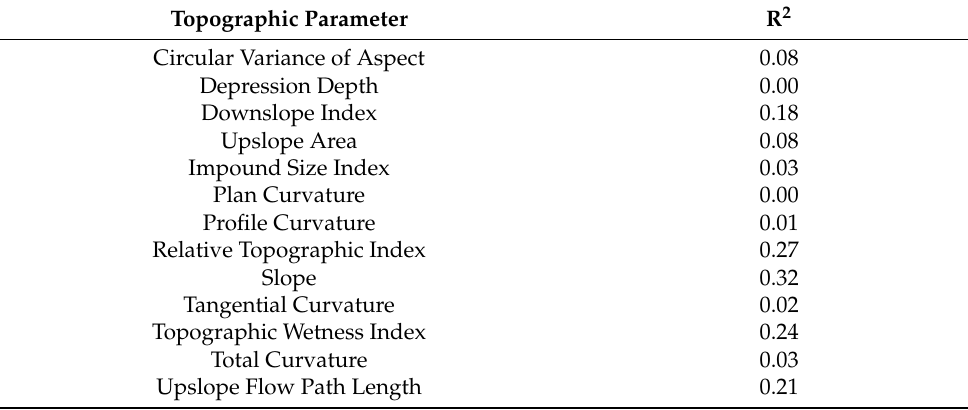
Table 3. Coefficient of determination (R 2 ) values from a linear regression between overall crop yields and topographic parameters (bold values are statistically significant at p <